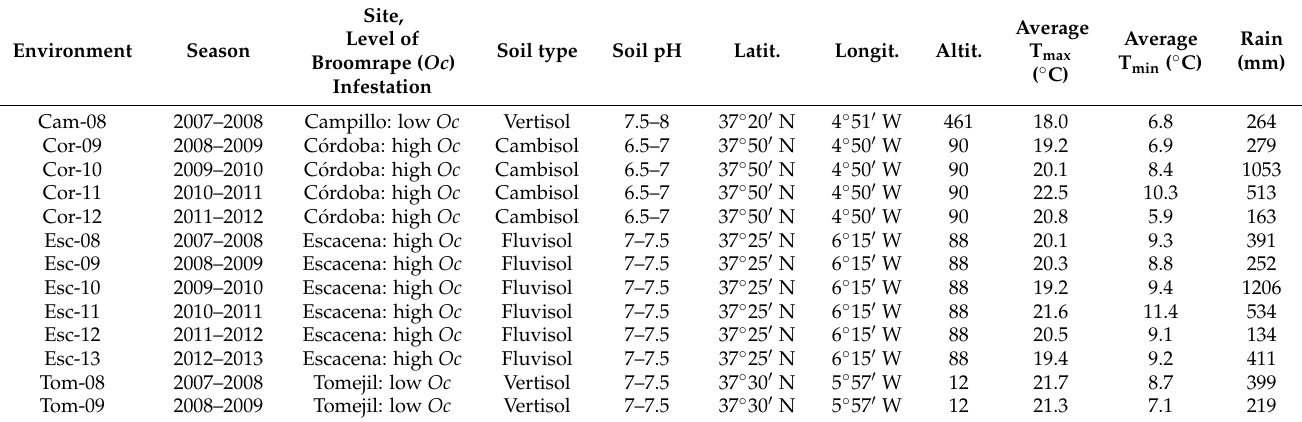
Table 2. Description of the environments (combination of location and season) of the trials for the multi-environment study. Summary climatic data corresponding to each growing season are